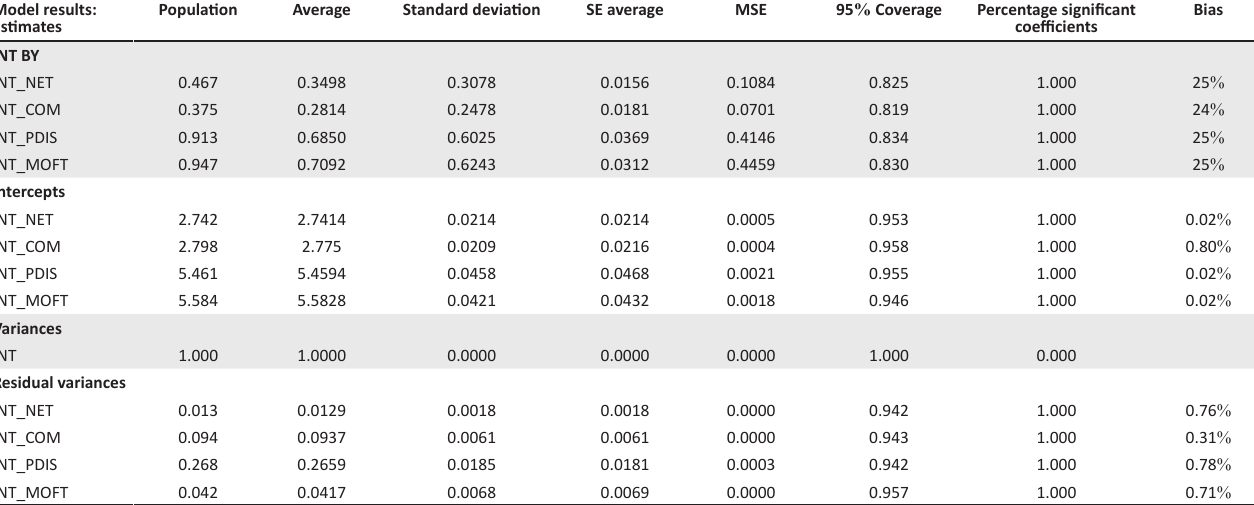
TABLE 10: Average population estimations with Mean Square Error, 95 % coverage, proportion of replications equal to zero under H0, and parameter bias. Model results: Population Estimates